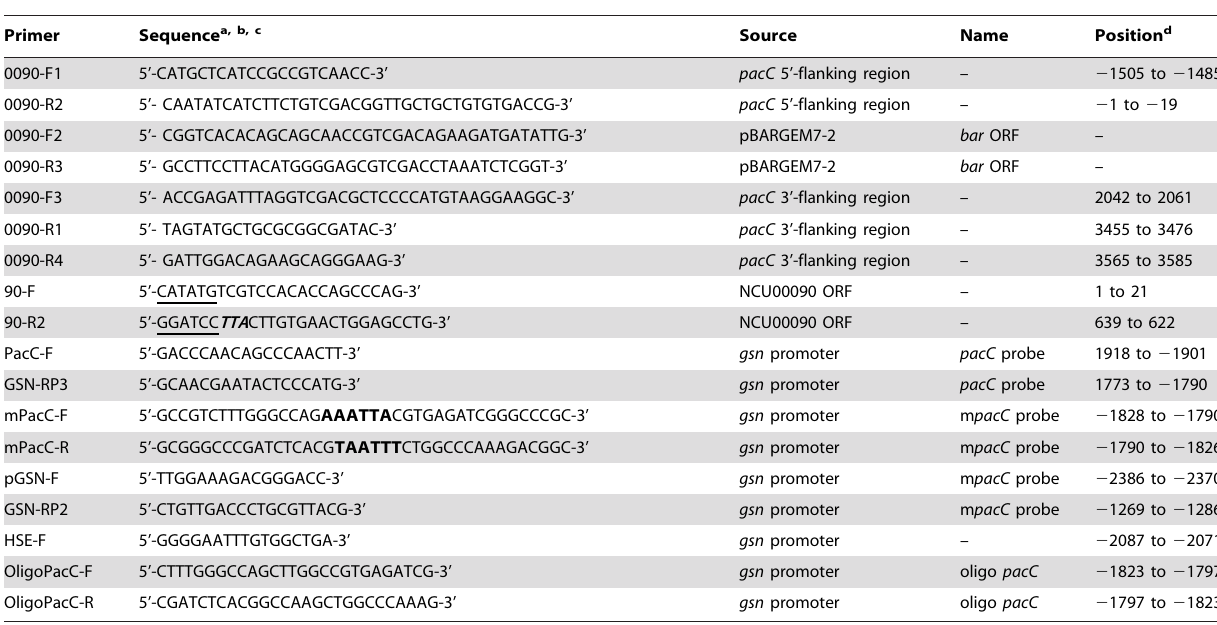
Table 1. Oligonucleotides used in this study.